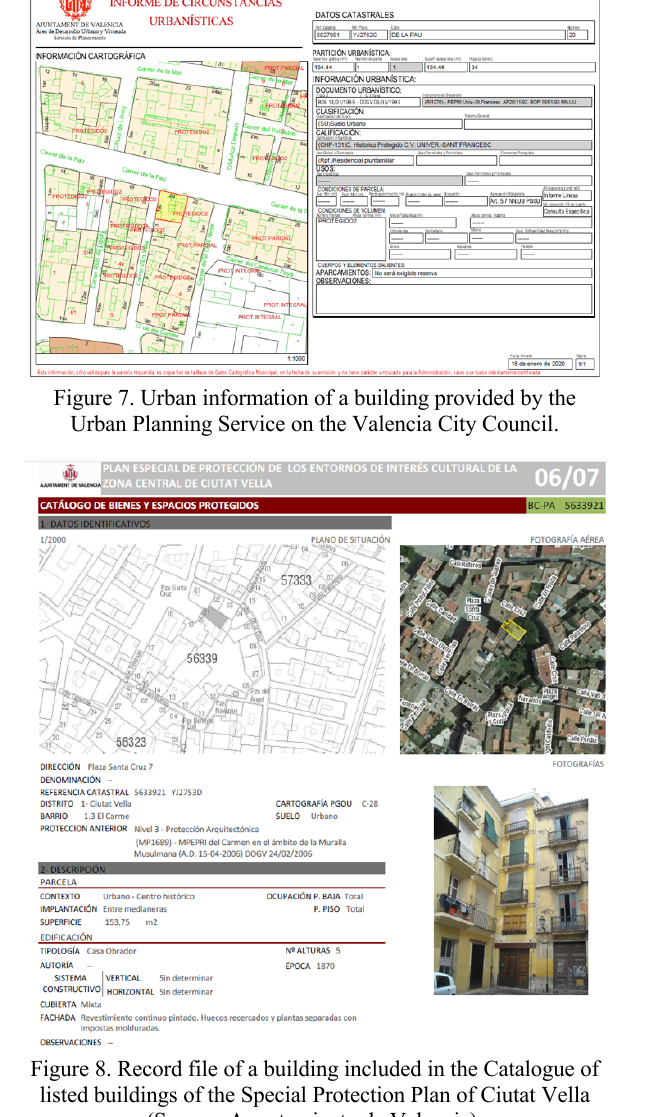
Figure 11. Structure plans, Moratin Street no. 3 (Source: Rieta Sister, 1941, Rieta Collection, CIA-ETSA).